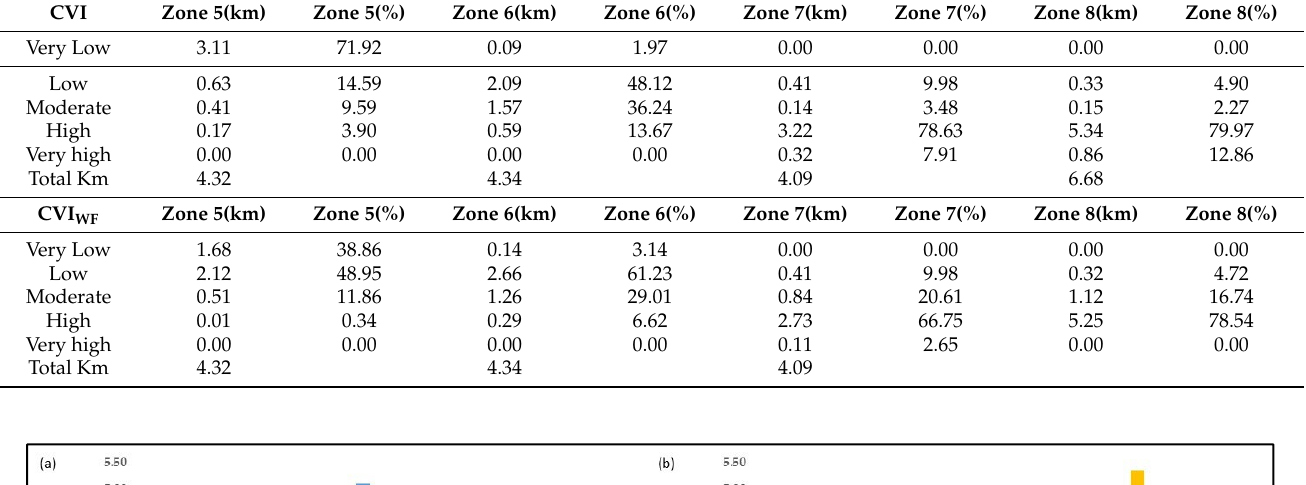
Table 5. CVI and CVI WF results in Zones 5–8 of the research area.